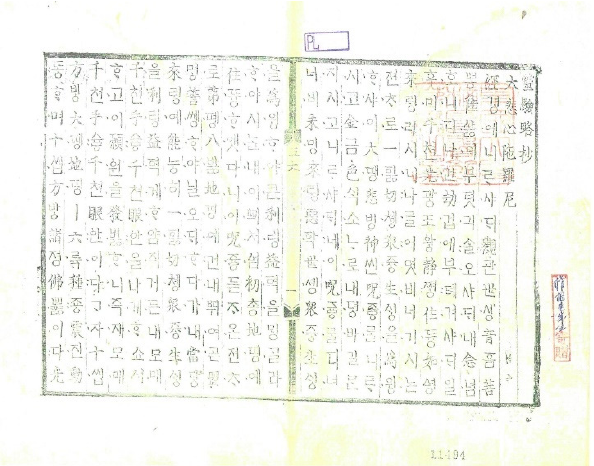
Figure 3. Vernacular Translation of Brief Transcriptions of Efficacious Resonance ( Yŏnghŏm yakch’o ŏnhae ) ( Odae chin ŏ n 1550, p. 2).